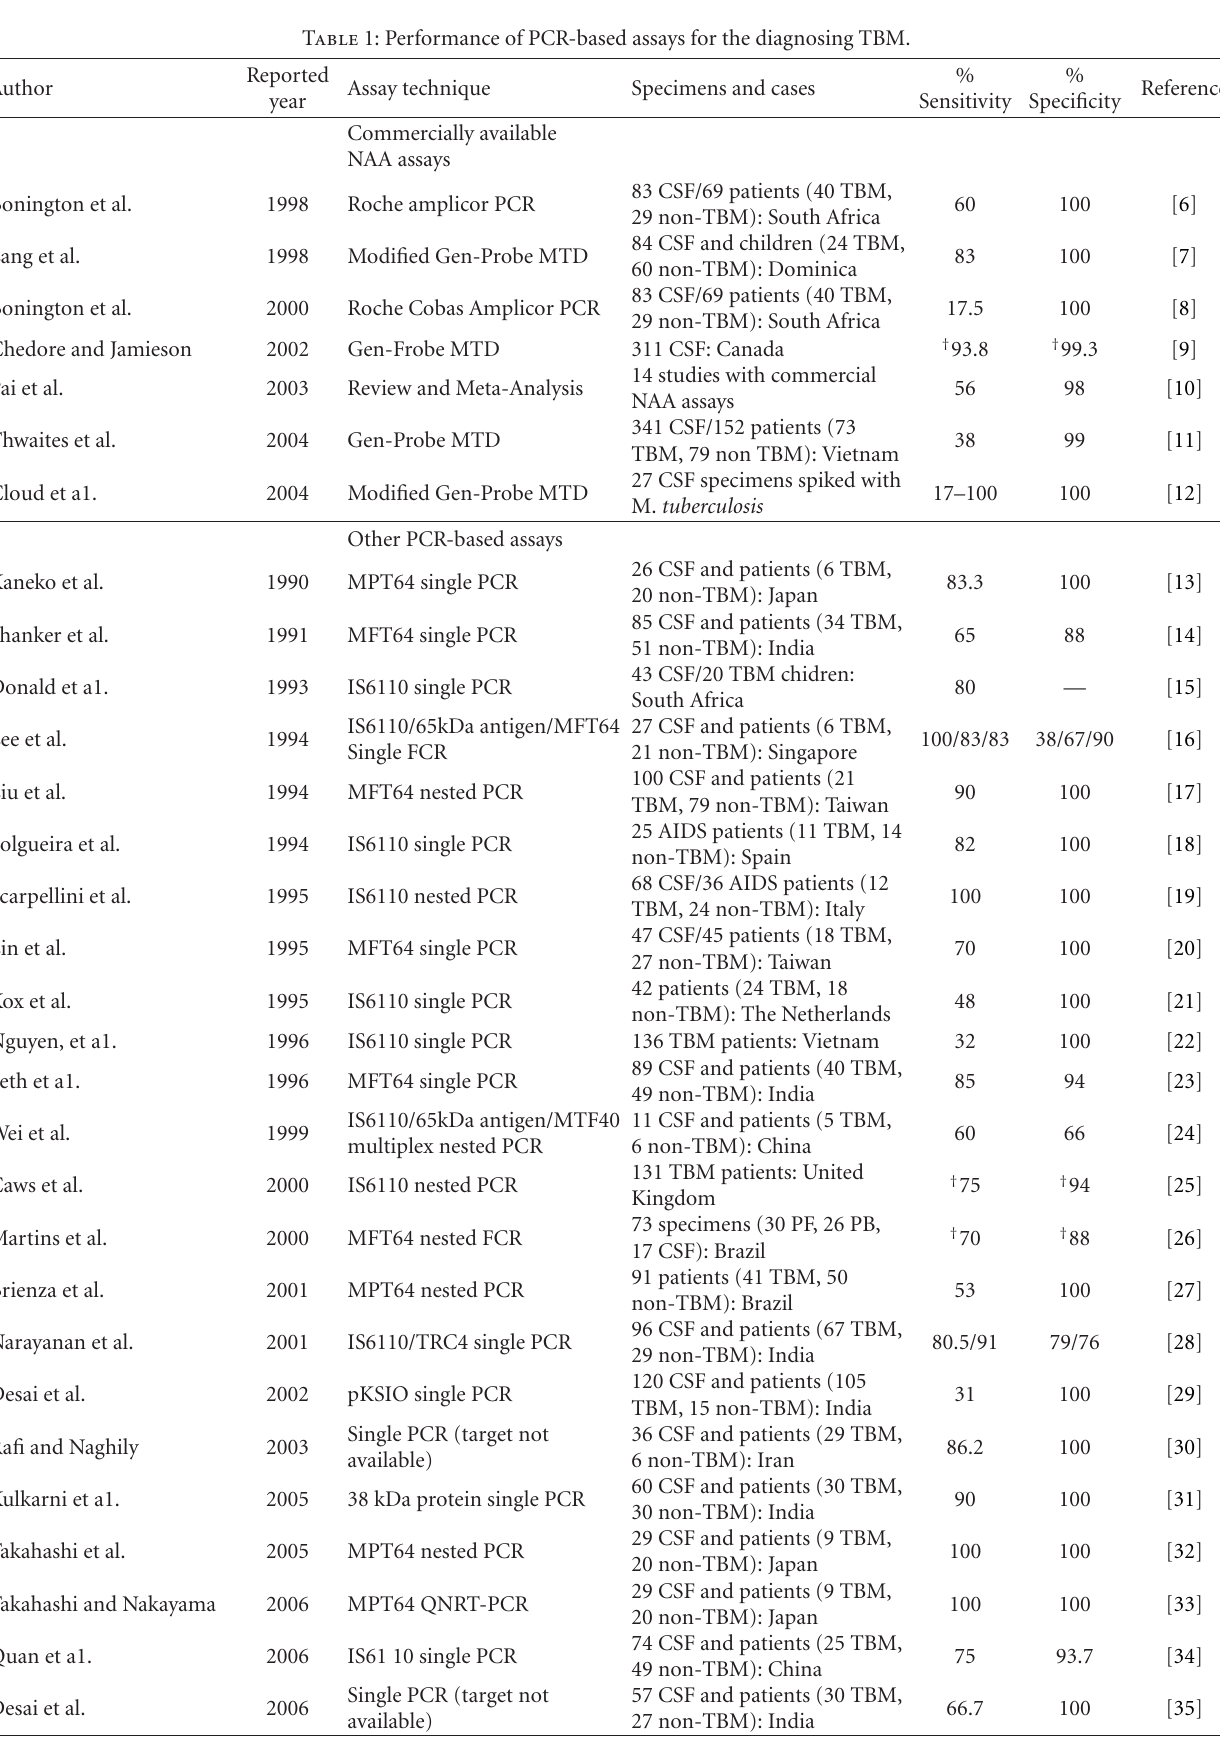
Table 1: Performance of PCR-based assays for the diagnosing